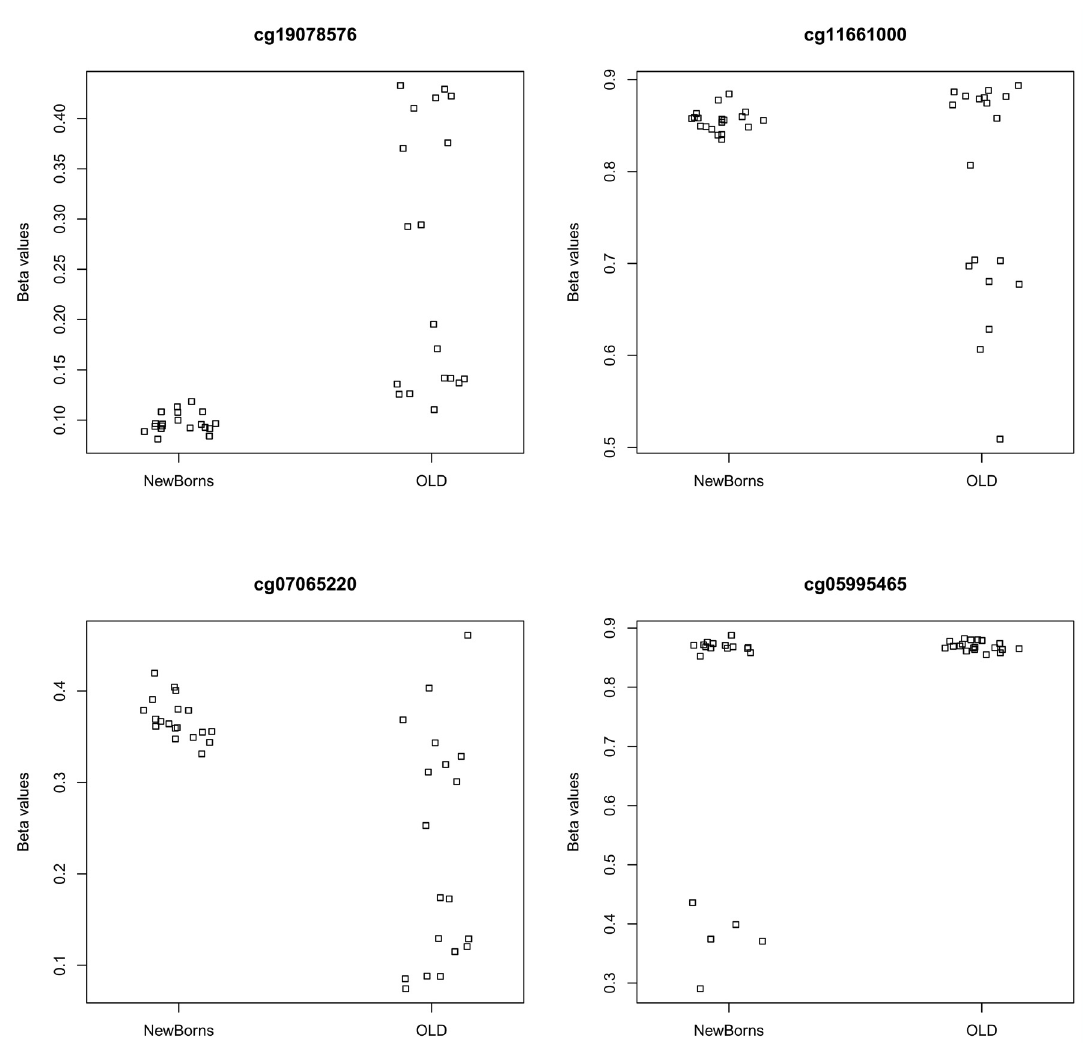
Figure 14. As for DMPs, it is useful to plot the top few differentially variable CpGs to check that the results make sense.